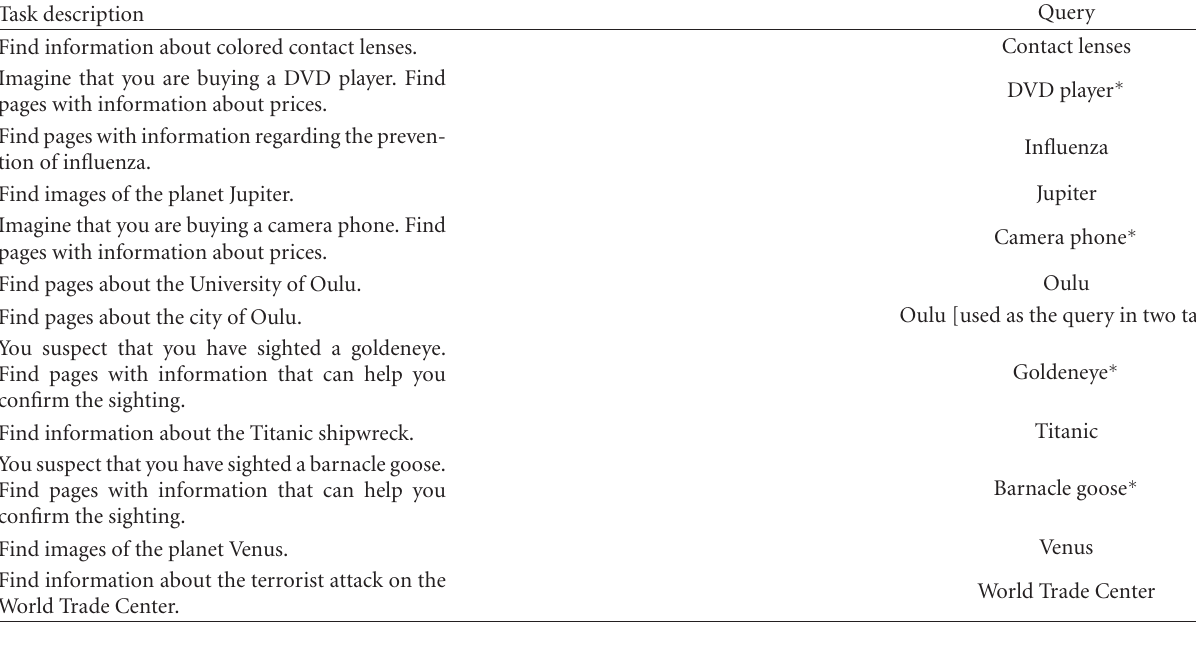
Table 1: Queries and task descriptions (queries marked with asterisk are translated from Finnish). Task description